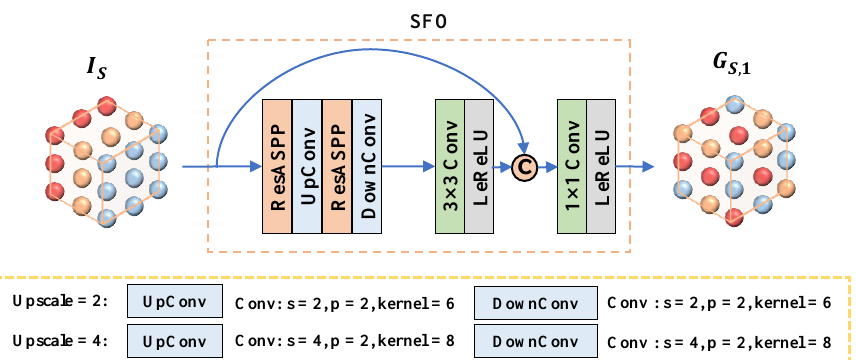
Figure 5. Detailed illustration of spatial interaction operator (SFO). Here, the size of each SAI is set to H = W = 3, which is used as a toy example. For better visualization of SFO, pixels from different channels are painted with different colors. The depth of the channel is set to 3 as an example. The proposed SFO can integrate features from different channels for each